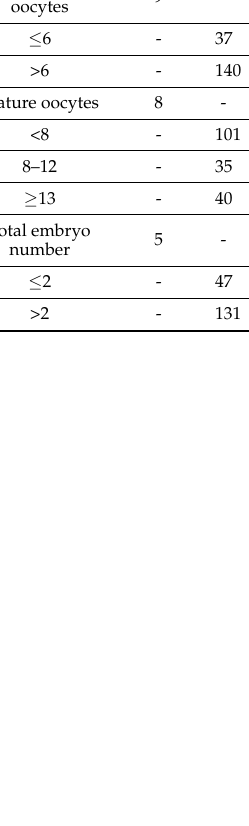
Table 4. Cell-free DNA levels according to retrieved oocytes, mature oocytes and total embryo number.